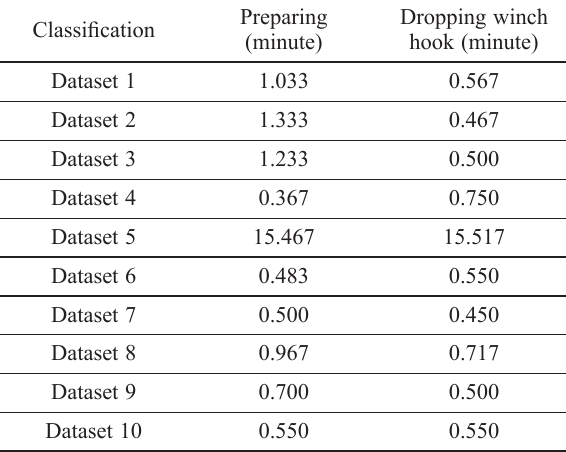
Table 8. Measured duration data for the activities of “ Preparing ” and “ Dropping winch hook ” in the installing process Preparing Classification (minute)